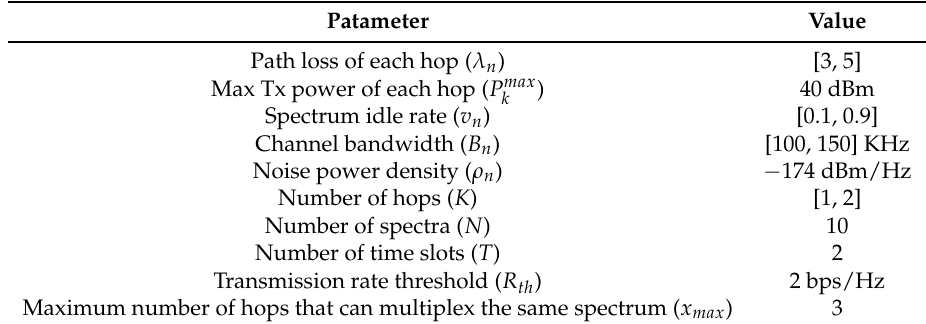
Table 2. Parameter settings in the multi-channel multi-hop (MCMH) simulation environment [26,27].